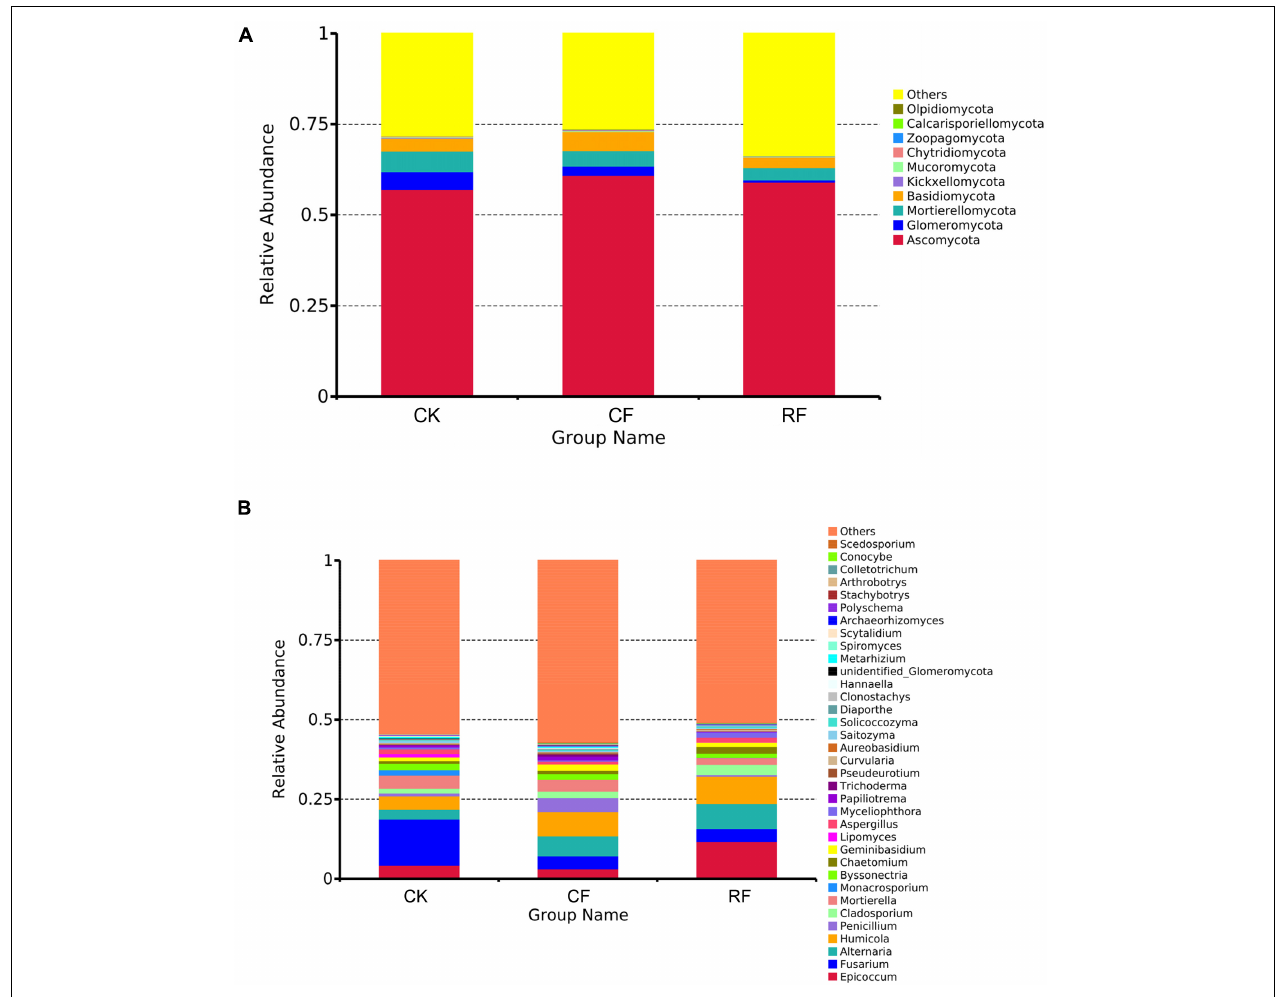
FIGURE 2 | Relative abundance of the fungal phyla (A) and genera (B) in the rhizospheric soil of cassava with fertilization. CK, CF, and RF indicate without fertilizer applied, with compound fertilizer applied, and with reduced fertilizer applied, respectively.